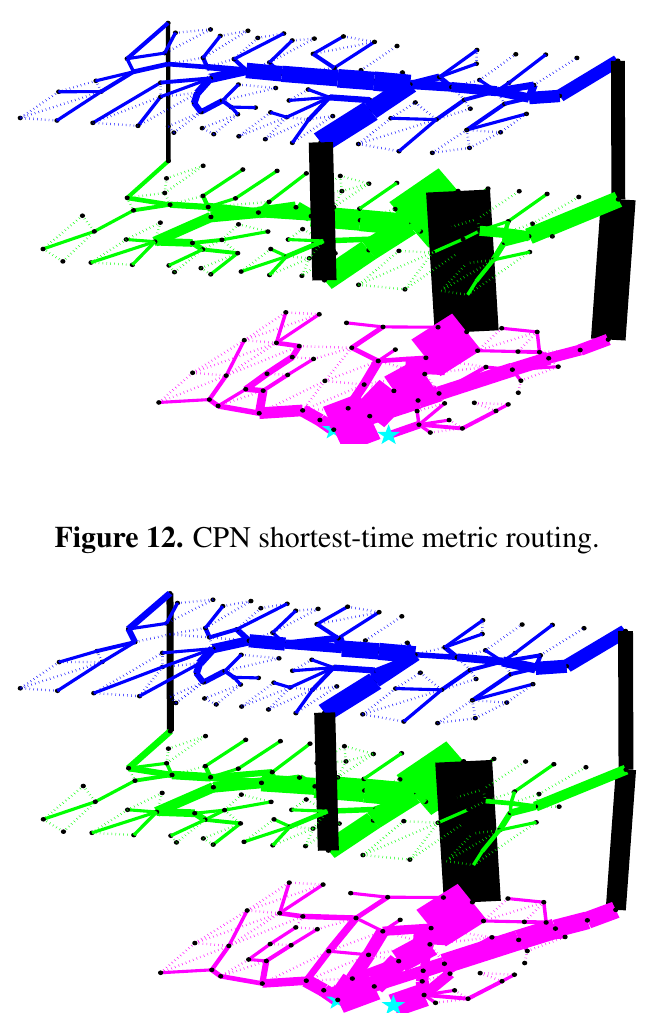
Figure 11. CPN shortest-path metric routing.